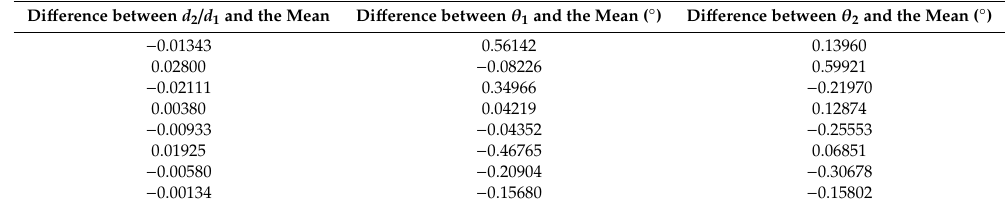
Table 2. Variation of the field-of-view parameters.